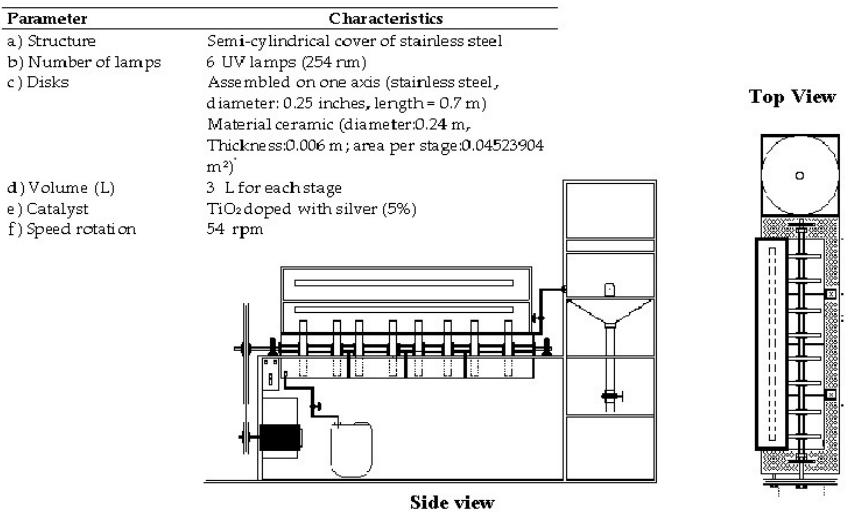
Figure 1. Schematic of the operation of the RFR adapted with UV lamps of λ = 254 nm, rotation speed = 54 rpm; the RFR has eight disks impregnated with TiO 2 -Ag catalyst.